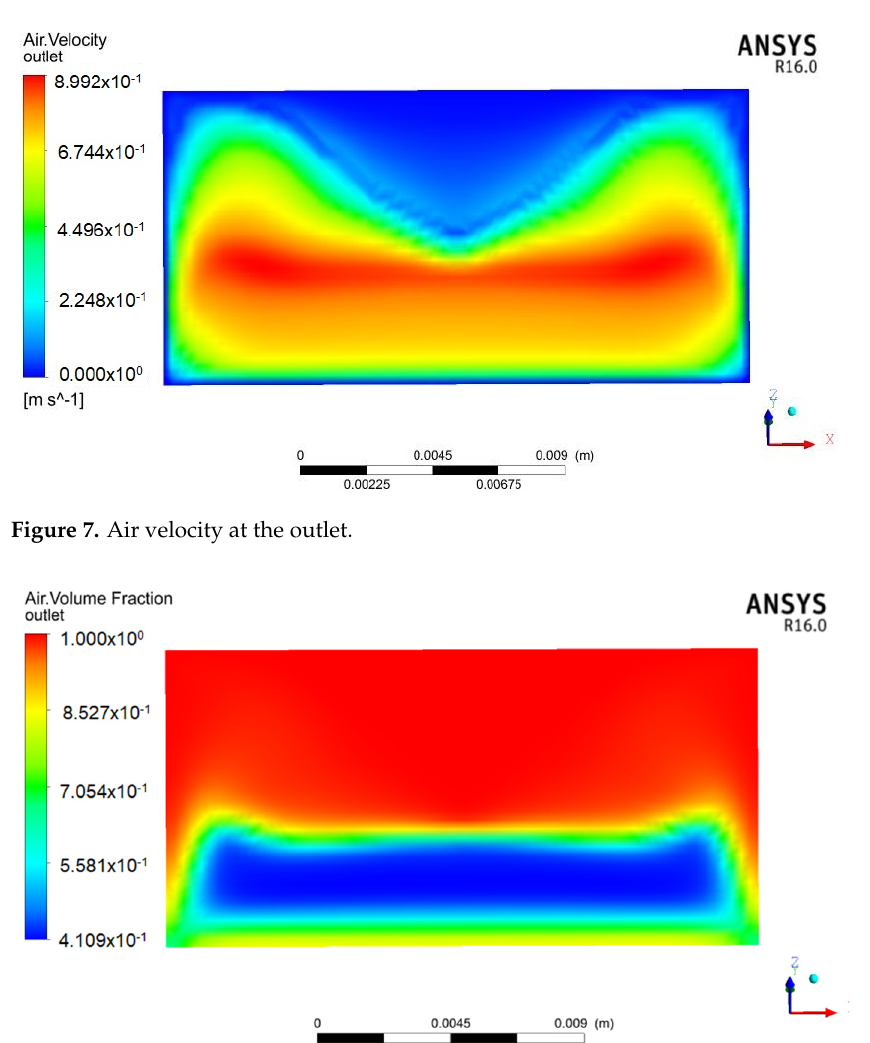
Figure 6. Sand volume fraction at plane 2.